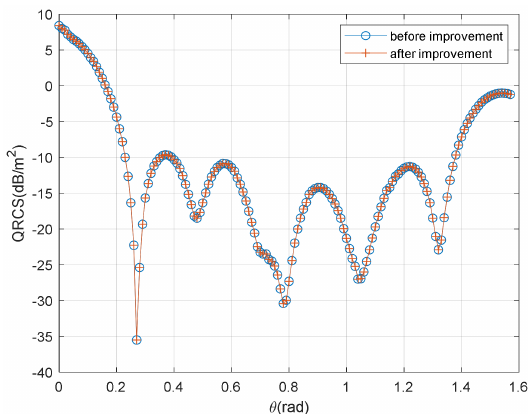
Figure 5. Verification of the simplified QRCS expression for